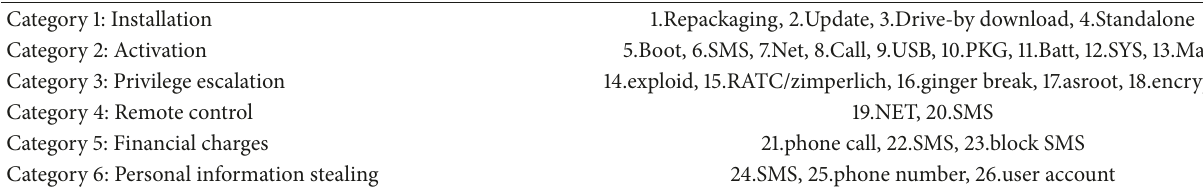
Table 1: Features in the Malgenome Dataset.